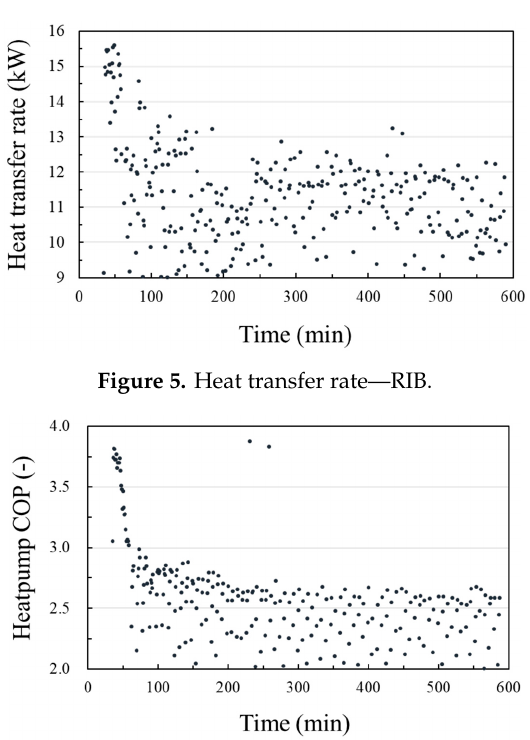
Figure 6. Coefficient of performance—HDPE.